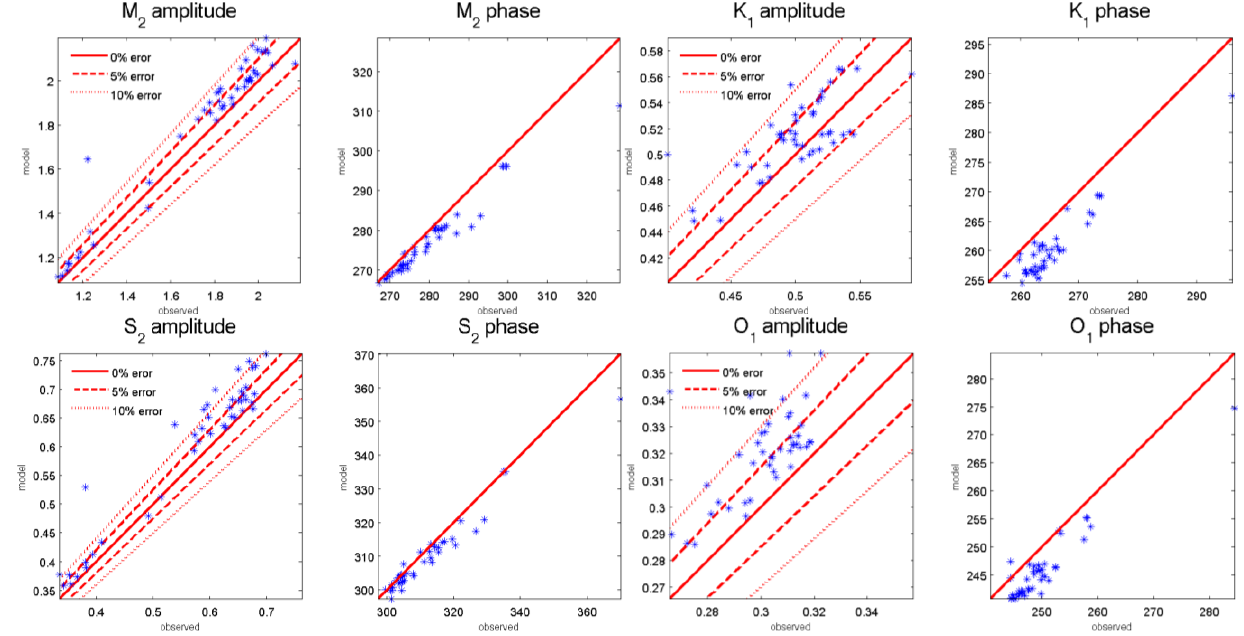
Figure 4. M , S , K and O model-observation comparison of amplitude (meters) and 2 2 1 1 phase (degrees) at 43 tidal stations in SE